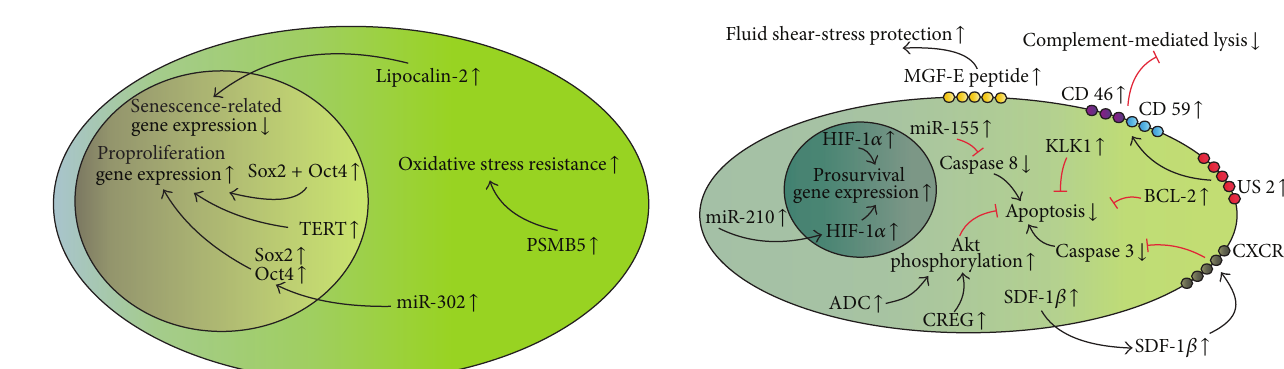
marrow-derived MSCs simultaneously overexpressing Sox2 and Oct4 genes were characterized by improved proliferative and differentiation potential compared to control cells [54] (Figure 3). Similar beneficial effects related to Sox2 and Oct4 overexpression were reported for adipose-derived MSCs [55].